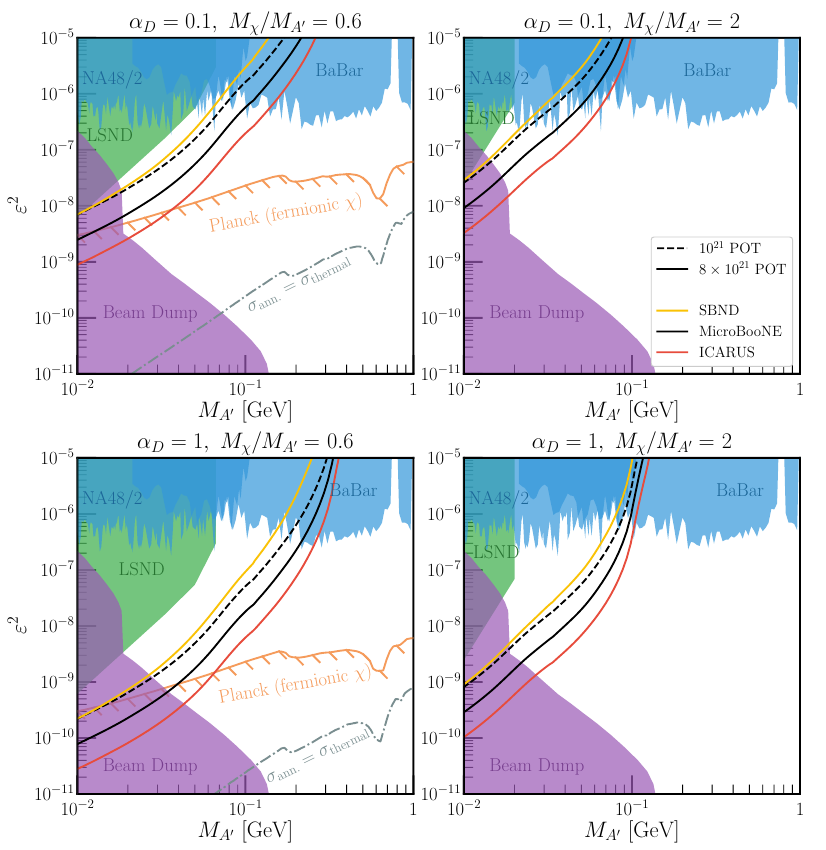
2 parameter space for which we expect 10 signal events Figure 2 . Solid lines: regions of M A 0 vs. " after 8 10 21 protons on the NuMI target have been accumulated. The gold line corresponds to (cid:2) the SBND detector, the black line to the MicroBooNE detector, and the red line to the ICARUS detector. The dashed black line corresponds to the region for which 10 signal events are expected at MicroBooNE, assuming 10 21 POT. The top (bottom) row corresponds to (cid:11) D = 0 : 1 ( (cid:11) D = 1). The left (right) panels corresponds to M (cid:31) = 0 : 6 M A 0 ( M (cid:31) = 2 M A 0 ). Here we assume the dark matter relic abundance is symmetric. See text for more detail regarding existing